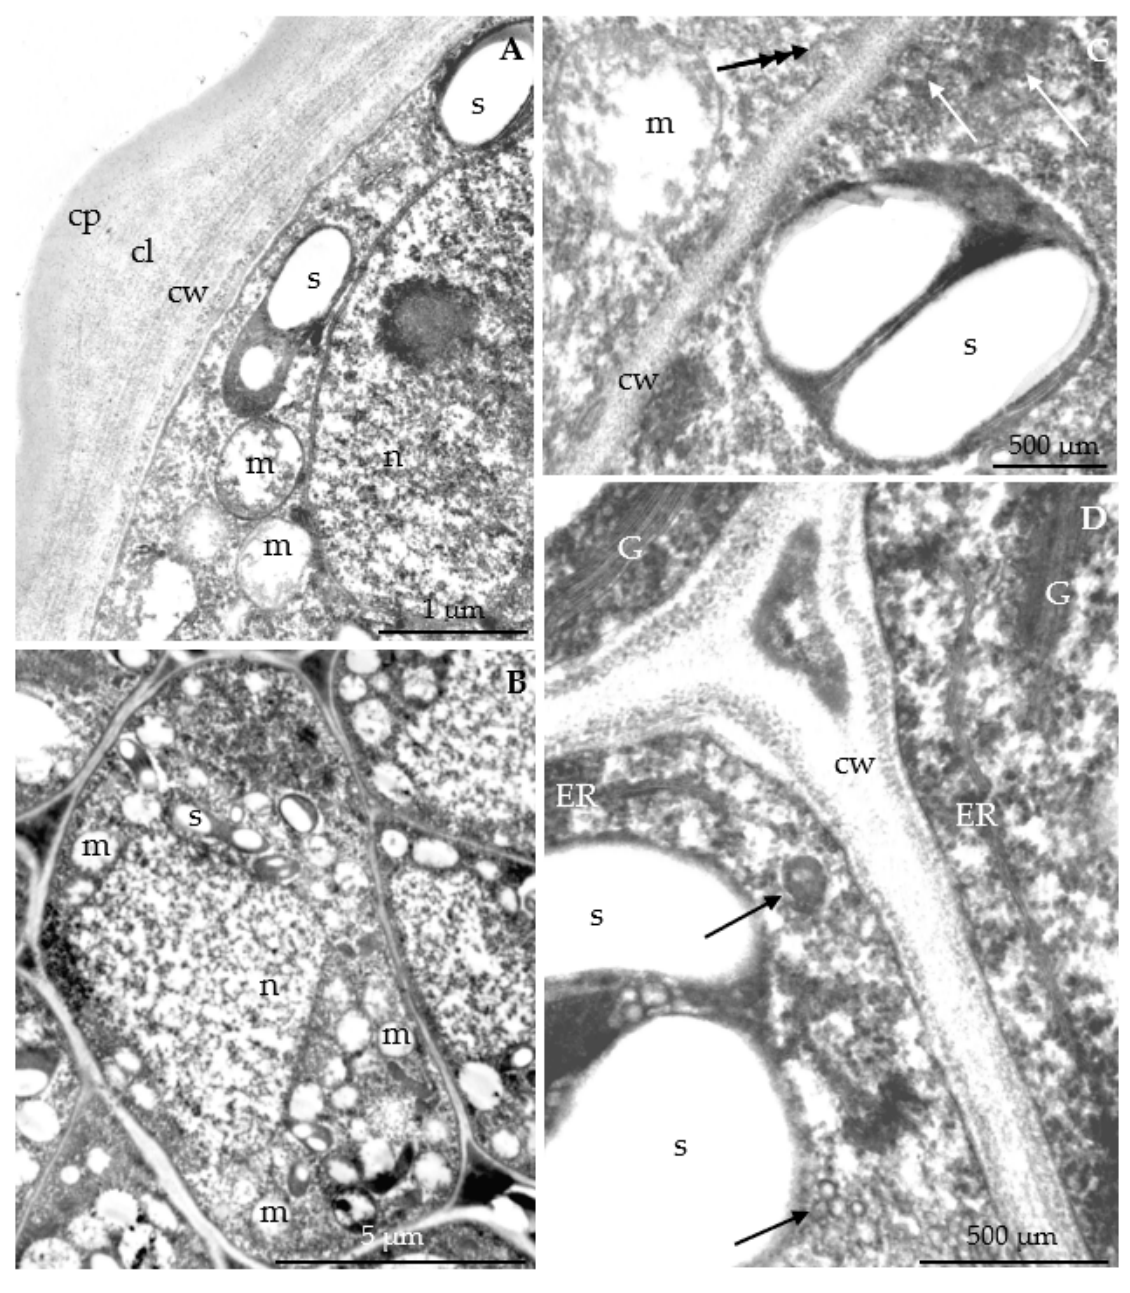
Figure 17. ( A – D ). Fragments of nectary epidermis ( A , C ) and parenchyma ( B , D ) cells in R. idaeus ‘Pokusa’ in the initial secretion phase. ( A ): cell wall (cw) with a visible cuticle proper (cp) and cuticle layer (cl), amyloplasts with starch grains (s), mitochondria (m), cell nucleus (n) with a nucleolus. ( B ): centrally located nucleus (n), numerous amyloplasts with starch grains (s), mitochondria (m). ( C , D ): transport vesicles (arrow), mitochondrion (m), an amyloplast with large starch grains (s), vesicle fused with the plasmalemma (three-headed arrow) ( C , D ): transport vesicles (arrow), mitochondrion (m), an amyloplast with large starch grains (s), vesicle fused with the plasmalemma (three-headed arrow) (micrograph C), Golgi ap-paratus (G) at the cell wall (cw) and endoplasmic reticulum (ER), (micrograph D ).